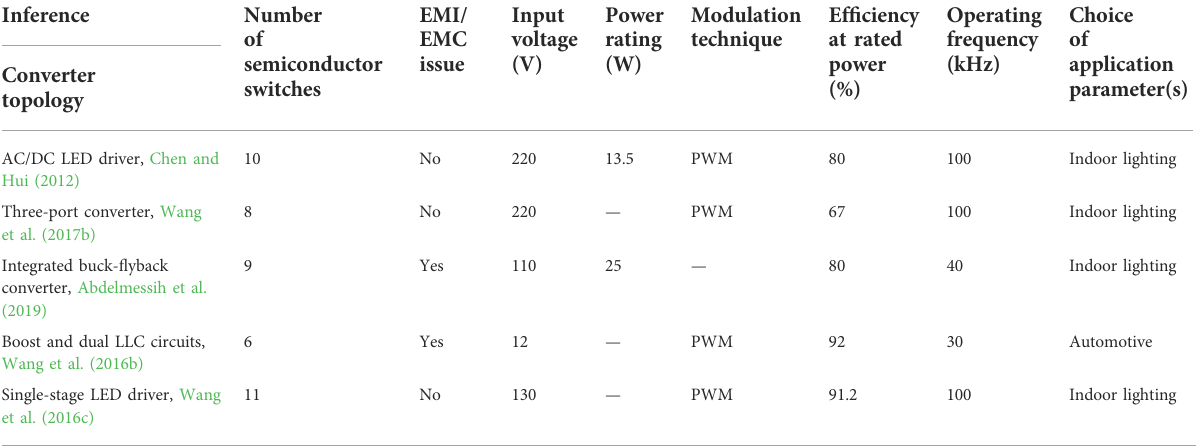
TABLE 4 Summary of various parameters of integrated stage converter topologies fed LED isolated drivers.